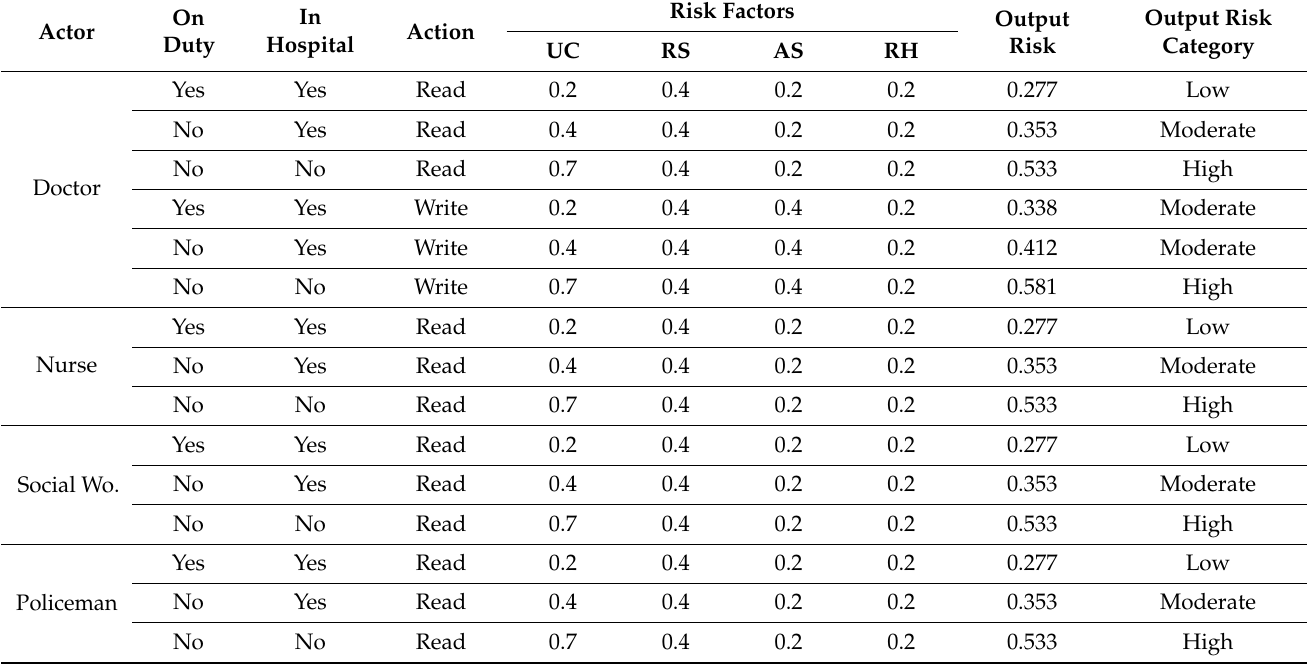
Table 10. Access decisions of various scenarios of the MC children